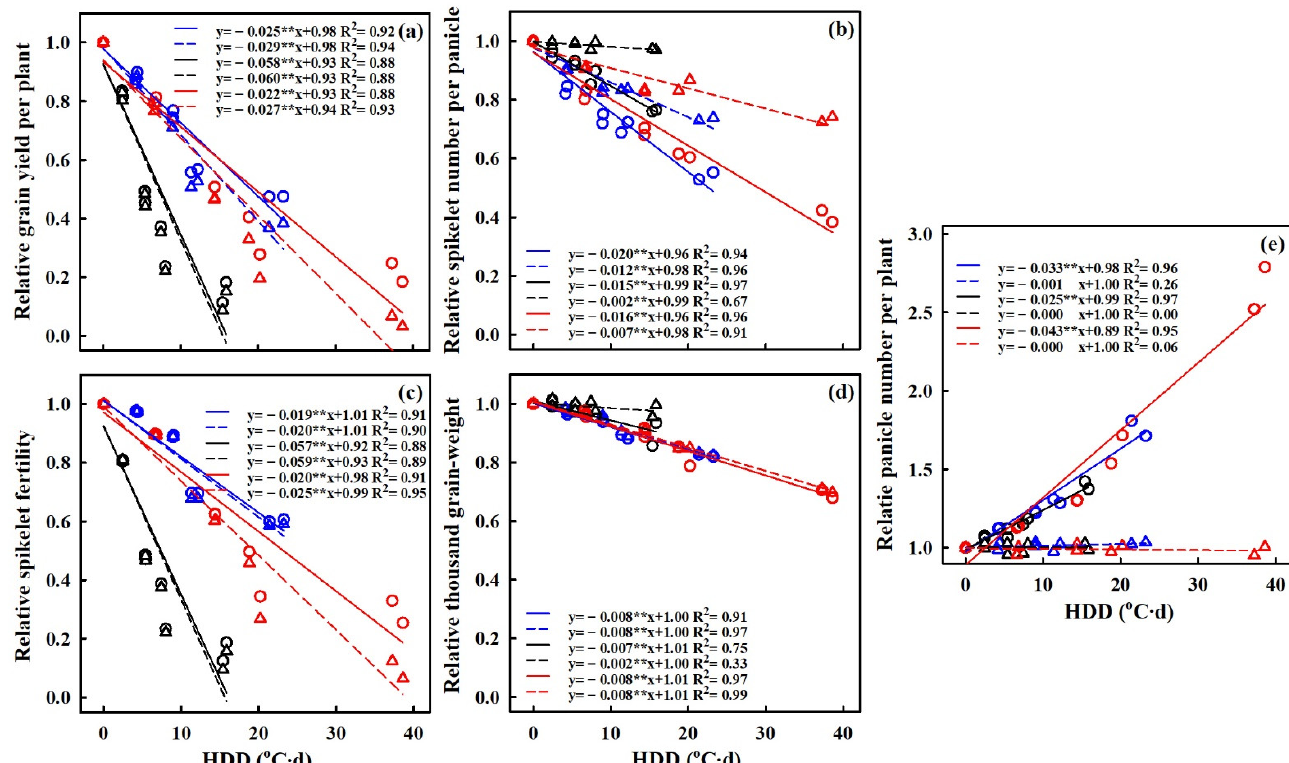
and solid line); (cid:35)